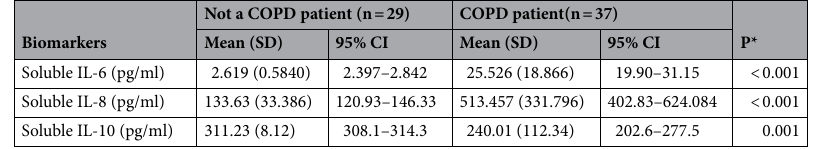
Table 3. Differences in soluble levels of IL-6, IL-8, IL-10 in COPD patients and non COPD patients. *Independent sample t test.